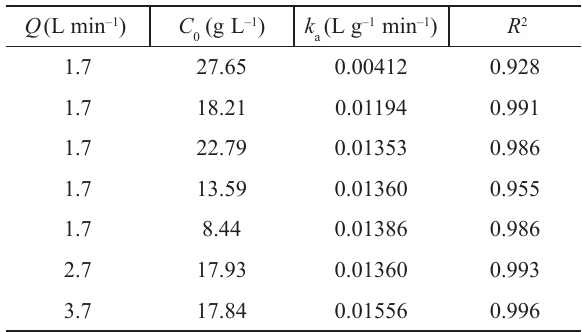
Table 5 – Parameters estimated for the Bohart-Adams